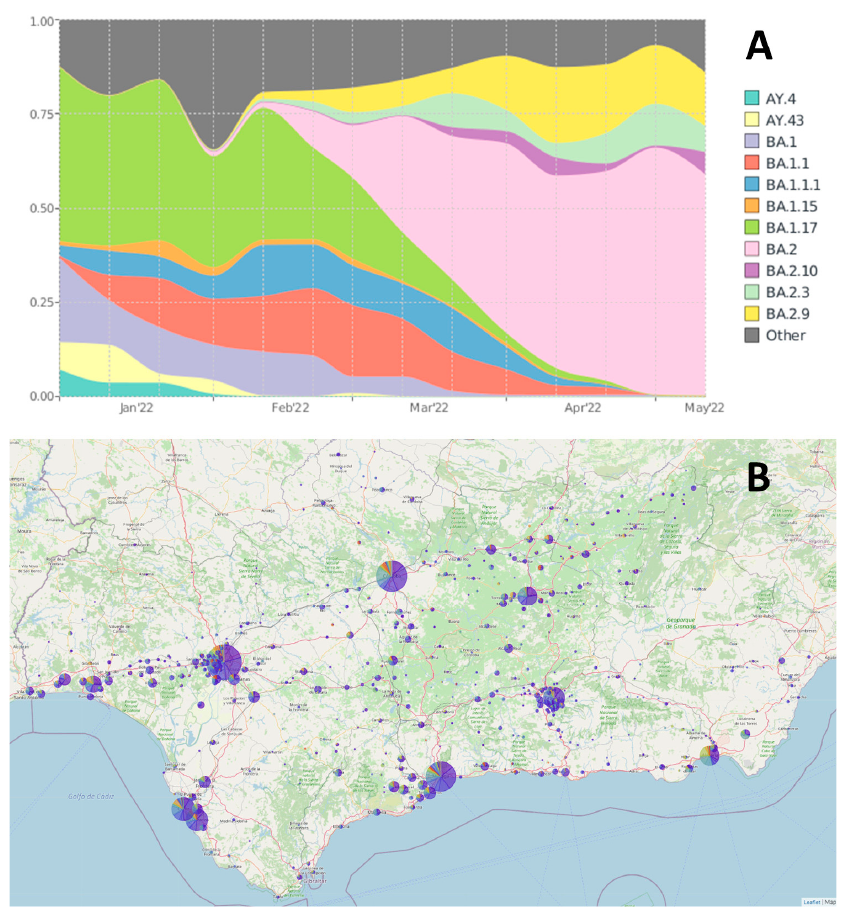
Figure 1. ( A ) Prevalence of main lineages in Andalusia in the period January to May 2022. ( B ) Epidemiologic map with the distribution of SARS-CoV-2 lineages in Andalusia in the same period.